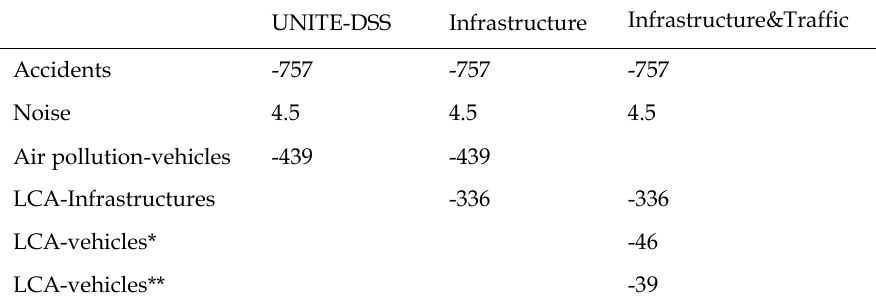
Table 5. Project externalities by components (million DKK2015) UNITE-DSS